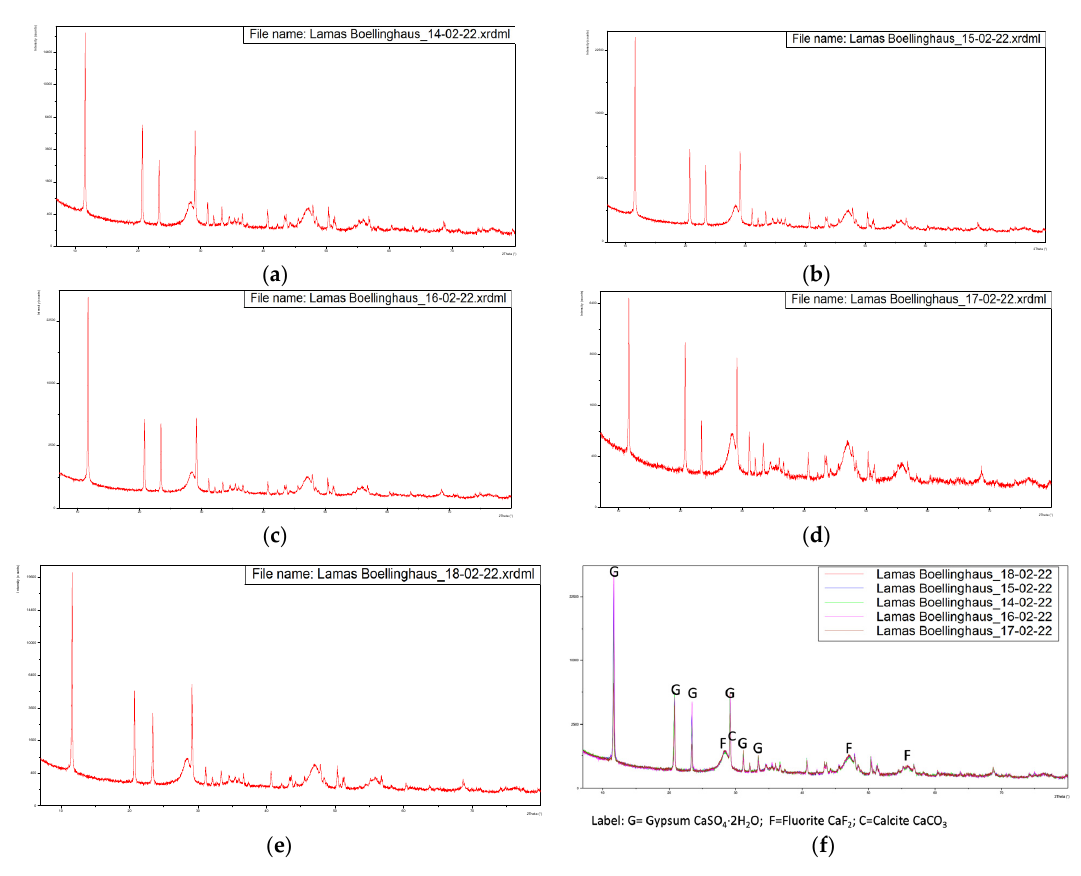
Figure 3. Diffractograms of the five samples dried at 60 °C with overlapping of the same. ( a ) Sample from 14-02-2022, ( b ) Sample from 15-02-2022, ( c ) Sample from 16-02-2022, ( d ) Sample from 17-02-2022, ( e ) Sample from 18-02-2022, ( f ) Overlapping of the previous diffractograms with identification of the main peaks.